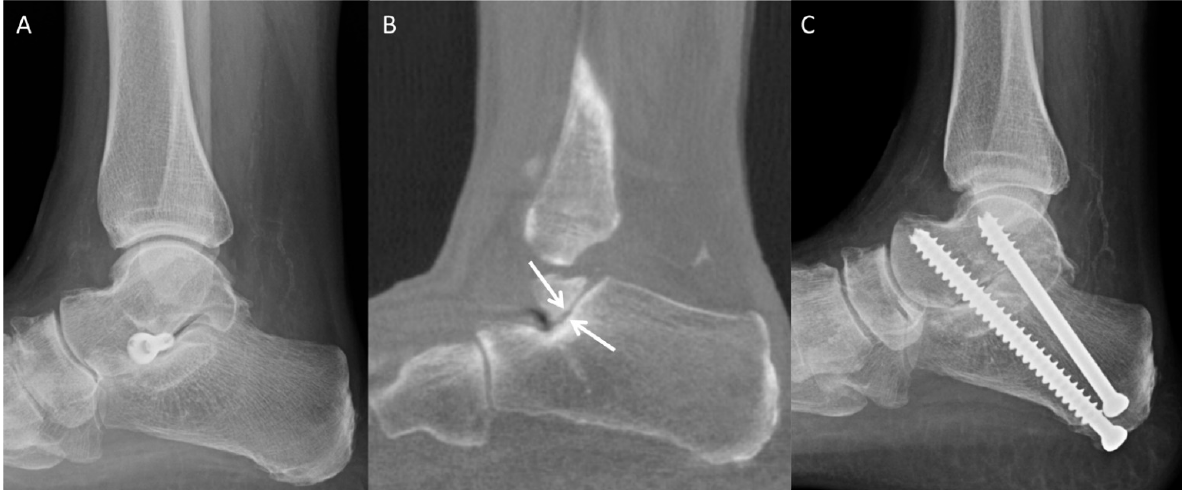
Figure 12. Prior left arthroereisis placement ( A ) developed hindfoot pain. Weight-bearing CT ( B ) demonstrates accelerated posterior subtalar facet degenerative changes (white arrows). Patient underwent implant removal and subsequent subtalar arthrodesis ( C ) with resolution of pain.